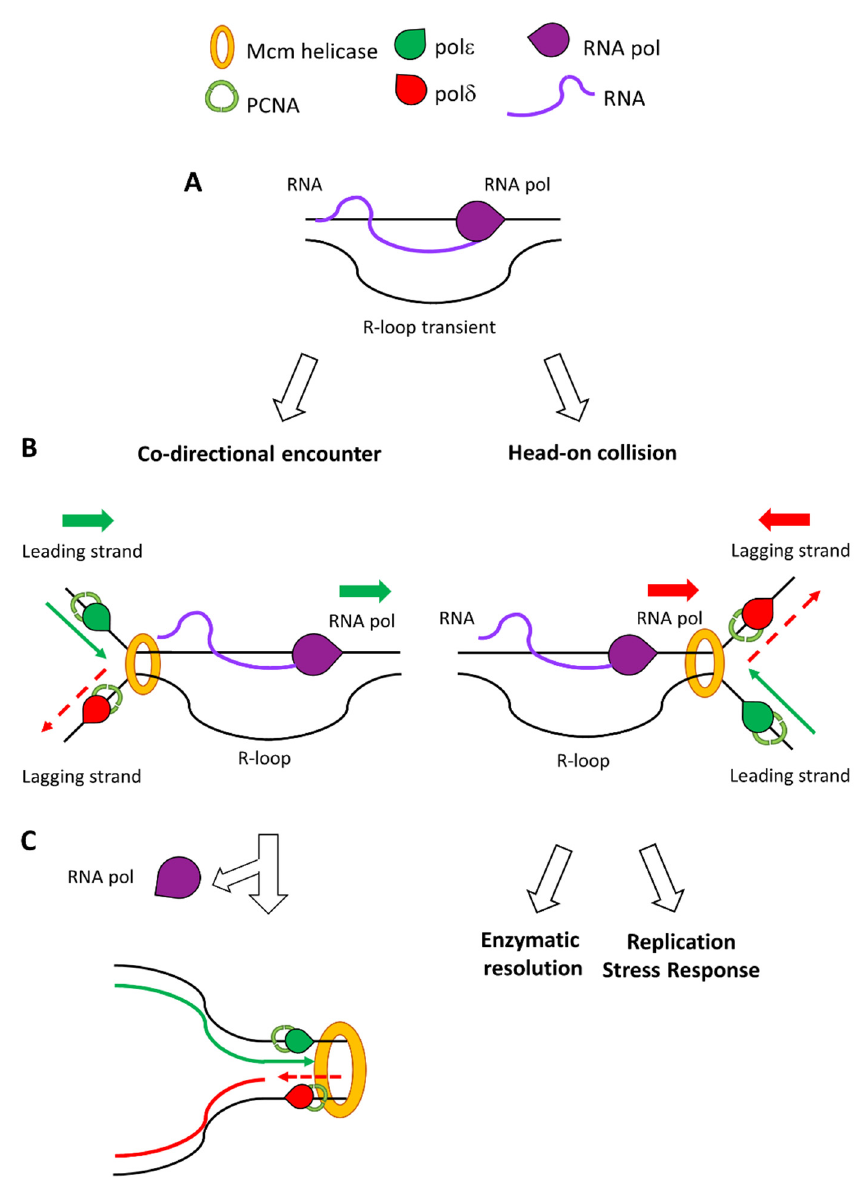
Figure 1. The orientation of the replication/transcription machineries determines the stabilisation of the R-loop and genome stability. ( A )R-loops are formed by the triple helical interaction between template DNA, the nascent RNA transcript and the complementary DNA strand ( B )When the RNA polymerase and the replication fork travel in the same direction, on the leading strand, the R-loop is displaced by DNA/RNA helicases associated with the fork (left panel). Differently, if the RNA polymerase moves towards the replication fork, on the lagging strand, the R-loop is more difficult to be resolved and may cause collision between the two machineries (right panel). ( C )The respective direction of the travelling machineries determines consequences on genome stability. If the R-loop is displaced, then replication can continue unaffected (left panel). On the contrary, if the R-loop is stabilised by colliding transcription/replication it may require active resolution and cause replication stress (right panel).